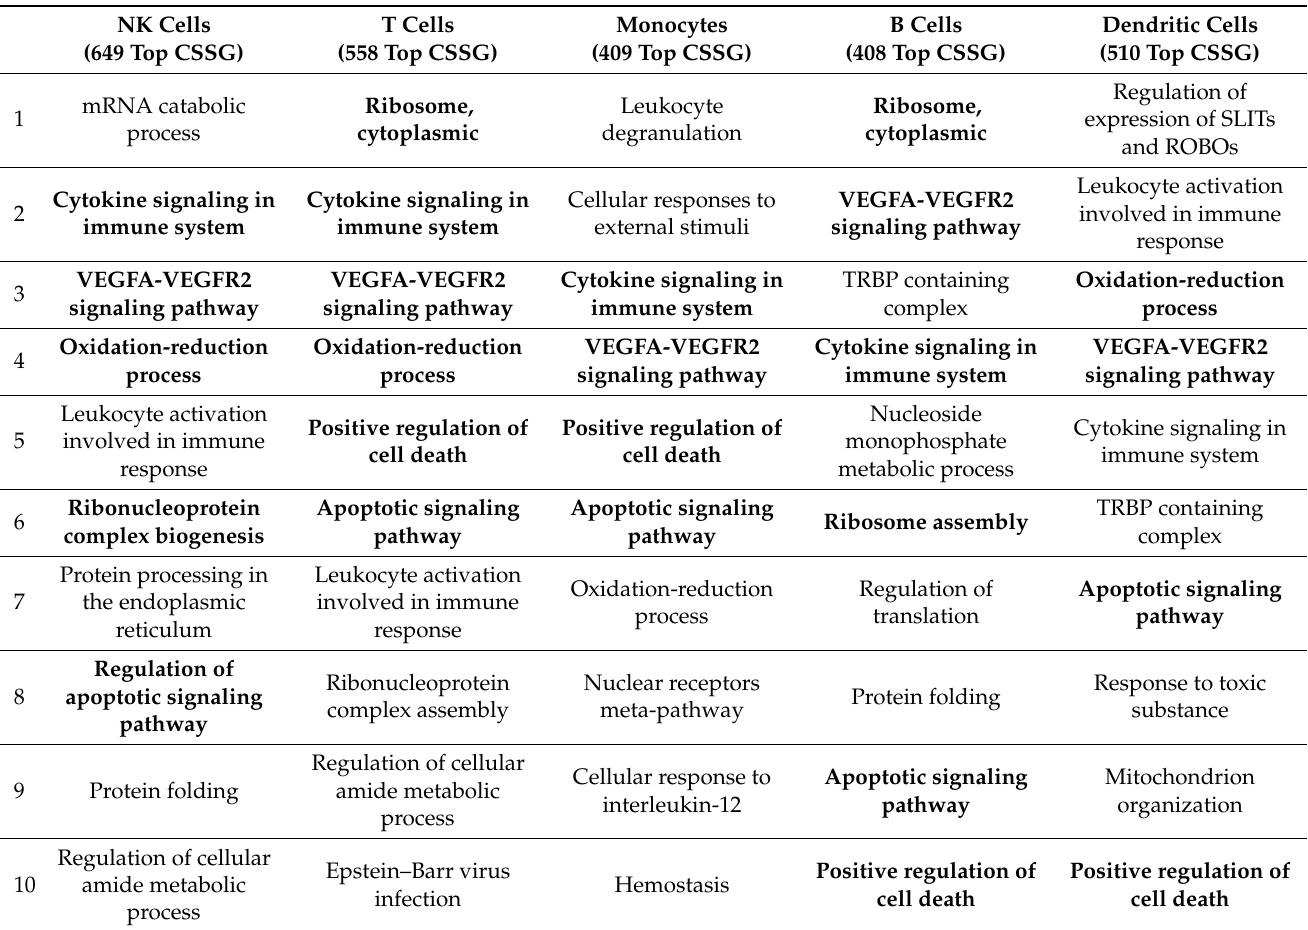
Table 1. Top ten biological functions most sensitive to chemical exposures in immune cells. Biological functions identified as most sensitive in more than one cell type are shown in